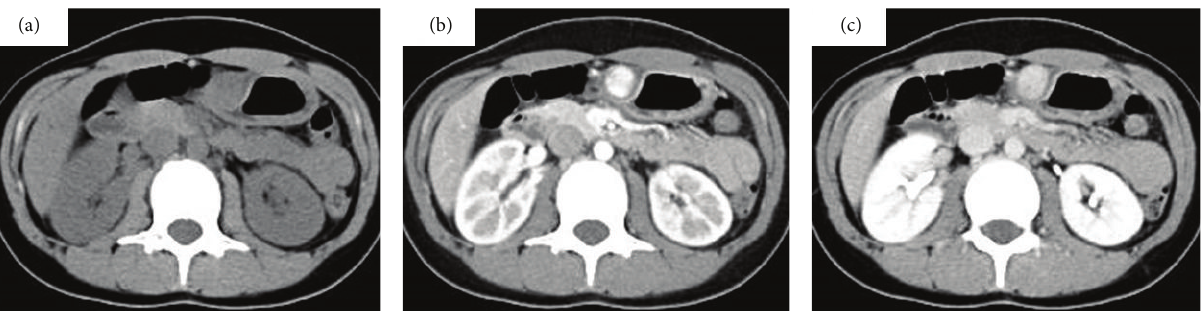
Figure 2: Computed tomography findings. Abdominal computed tomography revealed a well demarcated, ovoid mass at the antrum on (a) unenhanced, (b) arterial phase, and (c) delayed phase scans.